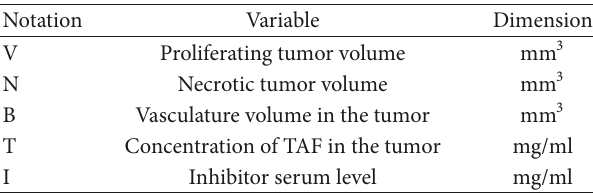
Table 1: State variables of the